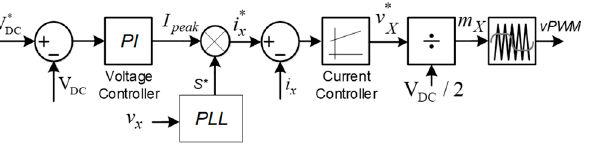
Figure 2. Cascade control scheme of the grid ‐ connected voltage source converter.